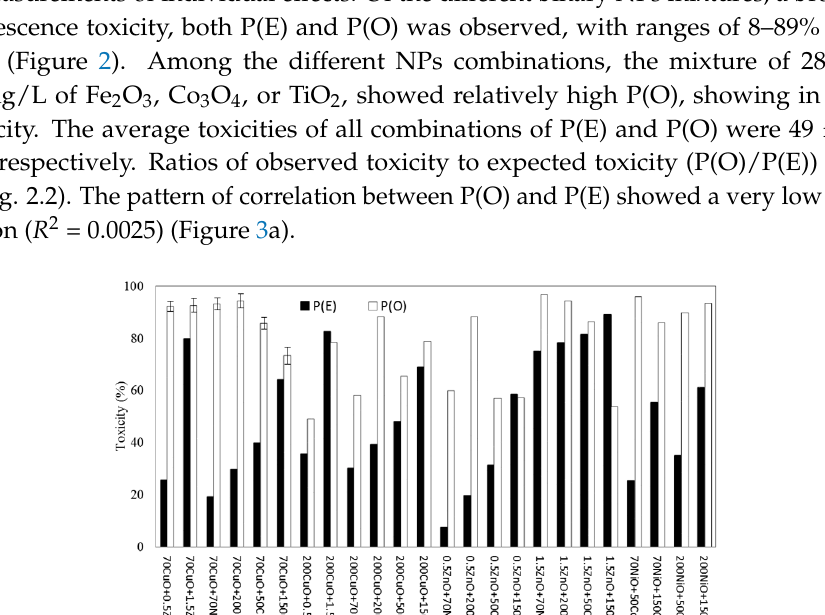
Table 1. Two concentrations of each nanoparticle (mg/L) used in various combinations to create binary NPs mixtures for the bioassays